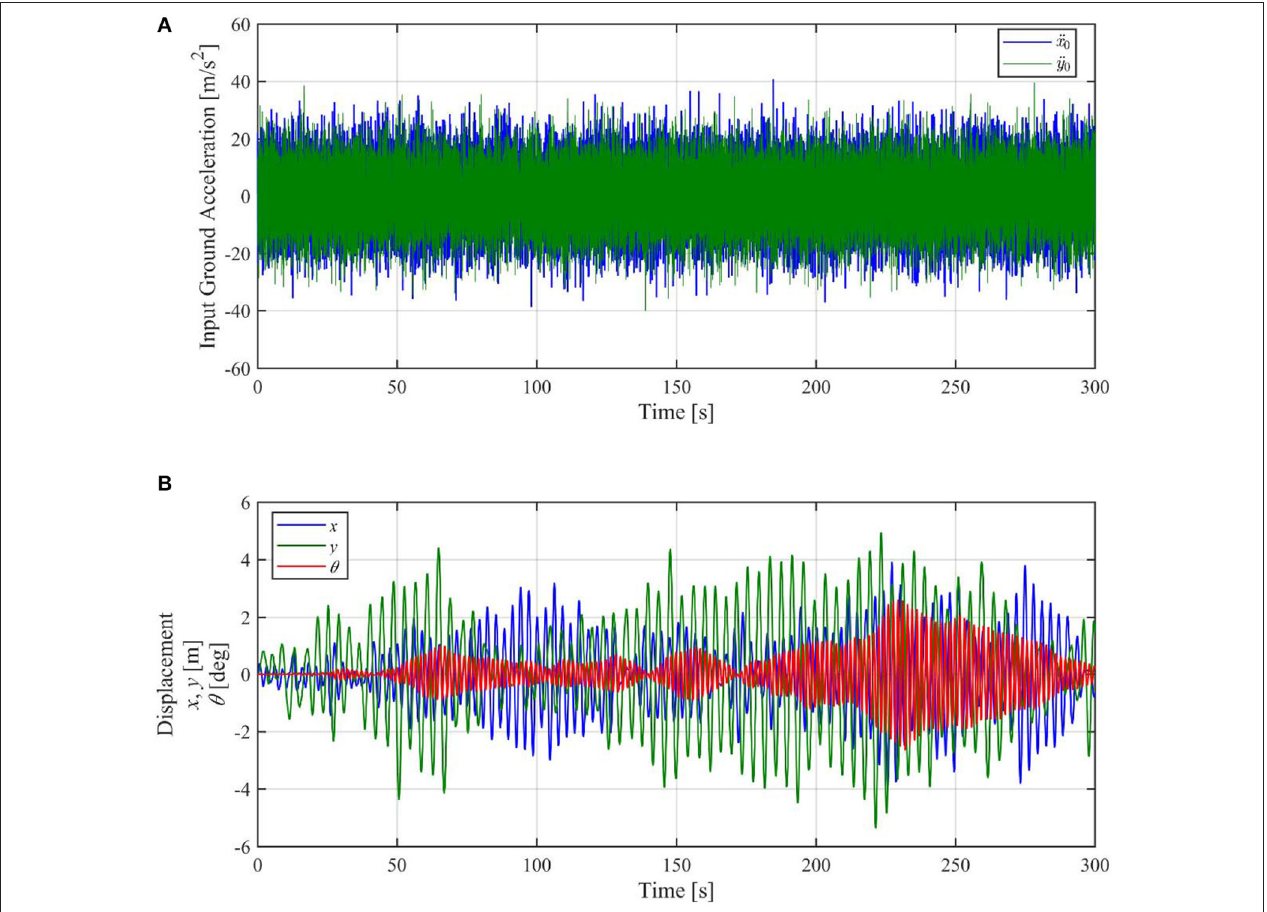
FIGURE 6 | Time-history analysis result of displacement response to uncorrelated two-directional white noise ground acceleration. (A) Input ground acceleration (B) Displacement